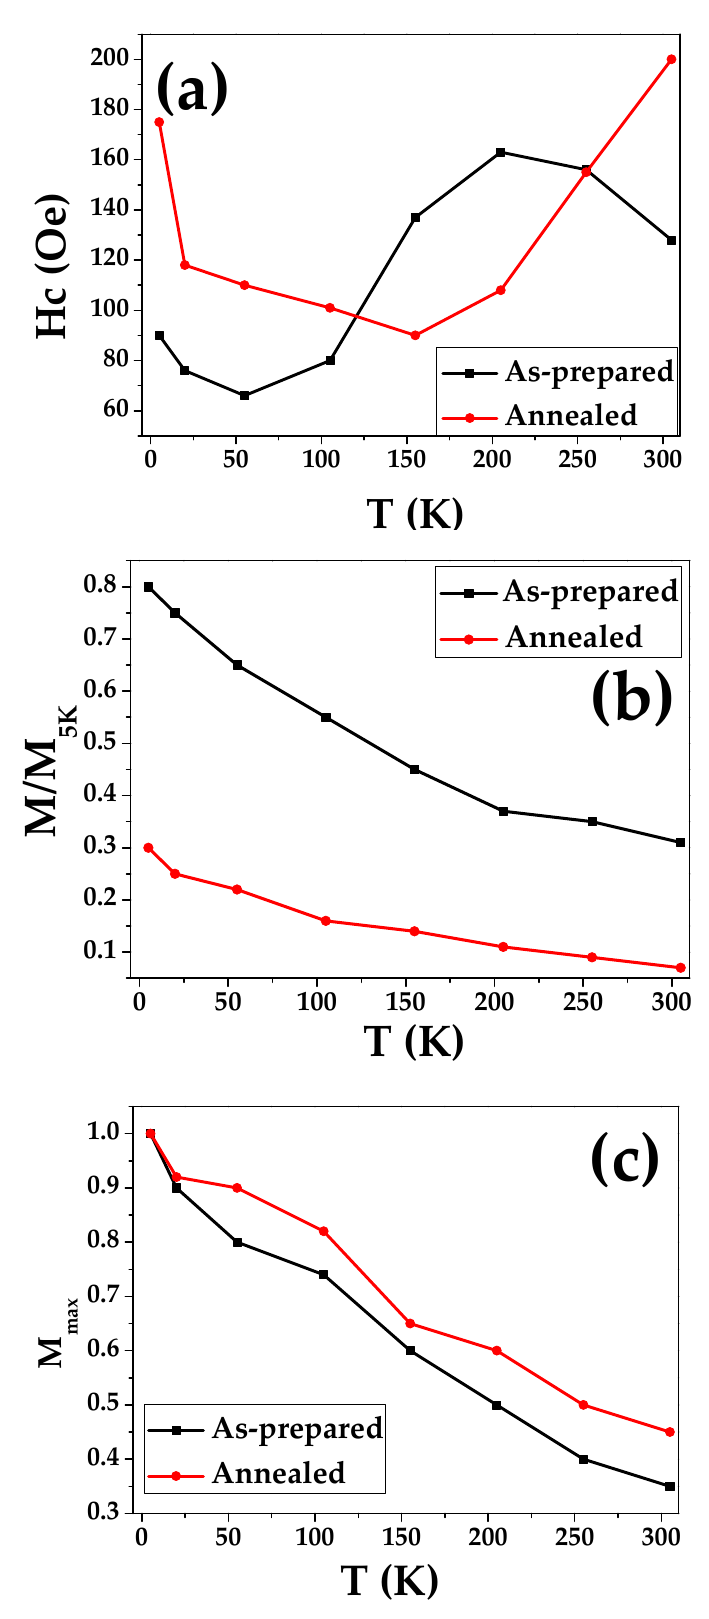
Figure 3. Temperature dependencies of coercivity ( a ), normalized remanence ( b ), and normalized saturation magnetization i.e., NM s ( c ) of Ni 2 FeSi glass-coated microwires, as-prepared and annealed at 973 K (1 h) (lines are just an eye guide).